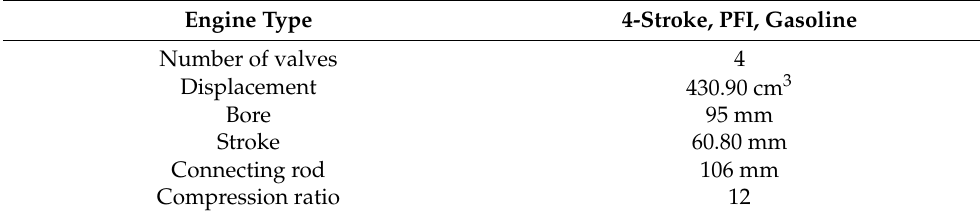
Table 1. Main characteristics of the Betamotor 430 cm 3